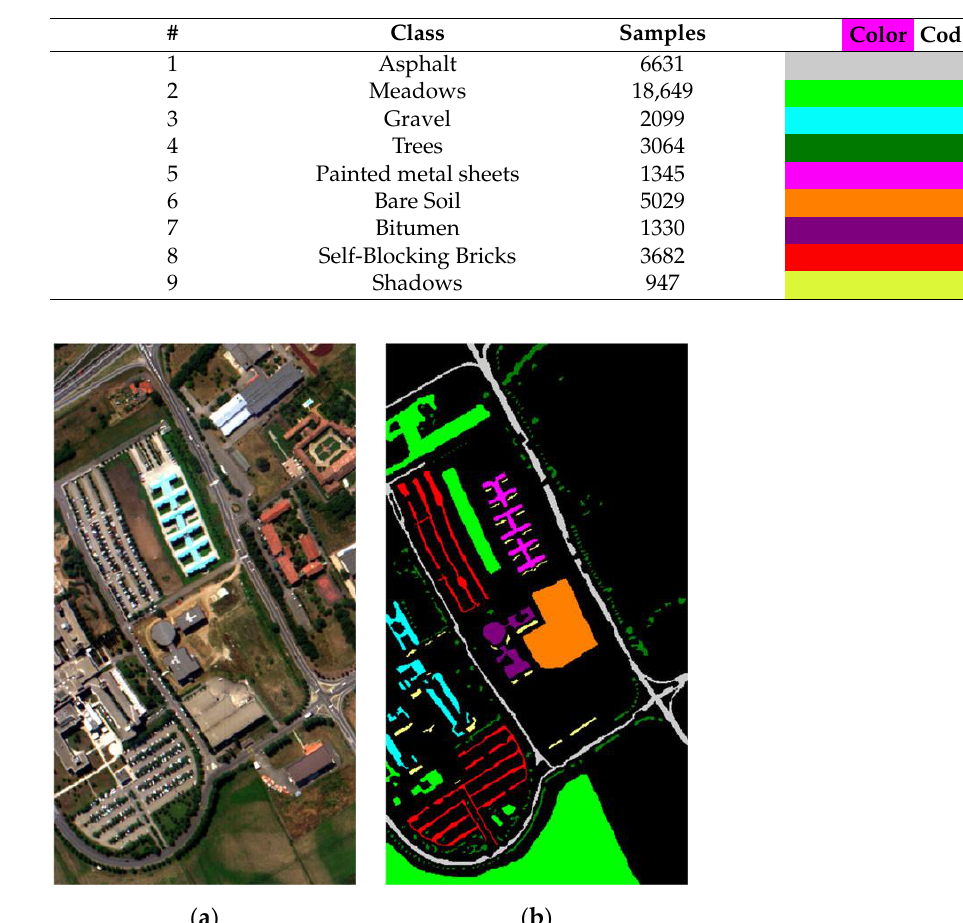
Figure 8. A scene sample of the Vaihingen dataset and the ground-truth map. ( a ) True color image; and ( b ) GT.